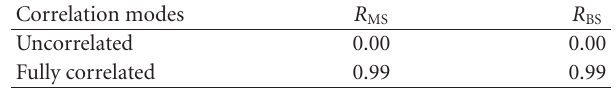
Table 5: Correlation